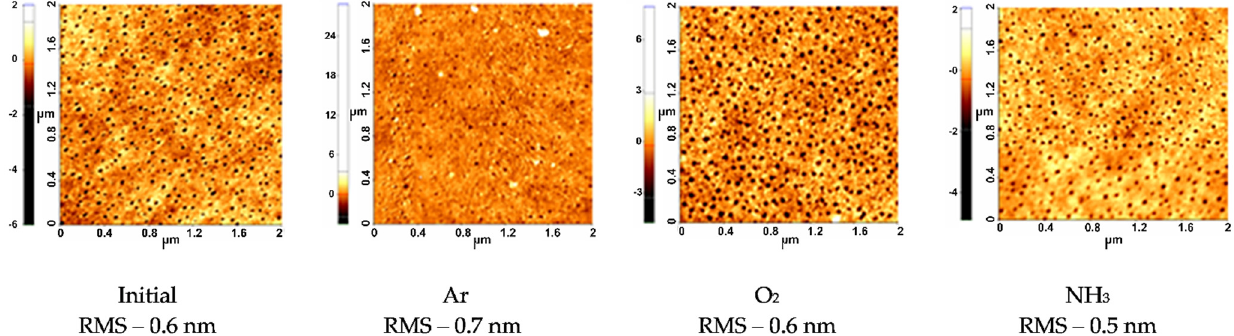
Figure 2. AFM images of the PNIPAAM coatings initial and upon plasma treatment of 30 s performed in various gases, at 20 W applied RF power and 0.5 mbar pressure.